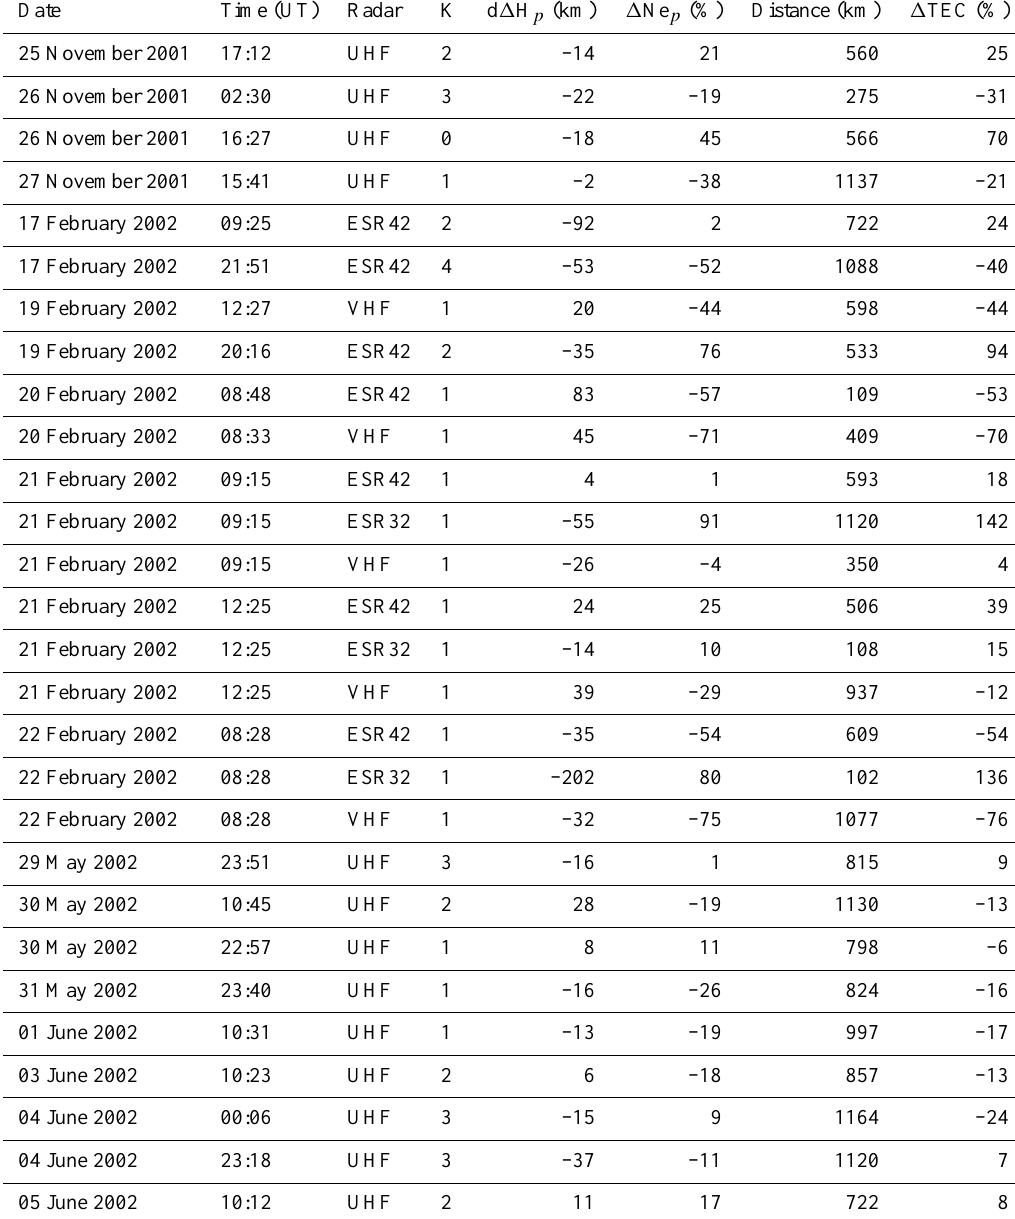
Table 2. Summary of all observed 28 occultation events. K is the local geomagnetic index for Tromsø. 1 H p =H p IRO –H p ISR , Ne p =(Ne p IRO –Ne p ISR )/ Ne p ISR , Distance=peak IRO –peak ISR , 1 TEC=(TEC IRO (150–420km) –TEC ISR (150–420km)) / TEC ISR (150–